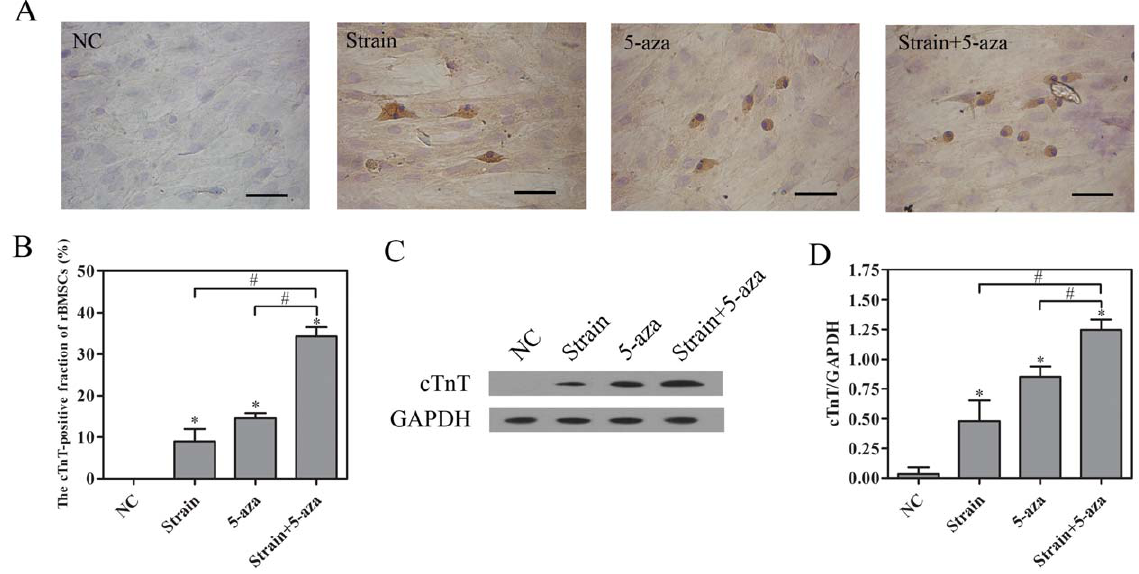
Figure 8. Effects of biochemical and physical stimuli on the expressions of cTnT in rBMSCs. rBMSCs were cultured under static conditions, or exposed to cyclic strain of 10% at a frequency of 1 Hz, or given 10 m M 5-aza, or treated with cyclic strain of 10% at a frequency of 1 Hz combined with 10 m M 5-aza for 24 h. The expression of cTnT was assessed on the 14 th day. (A) (B) Immunocytochemistry analysis of cTnT. Scale bar, 50 m m. (C) (D) Western blot analysis of cTnT. NC, negative control (rBMSCs treated with regular complete medium); PC, positive control (normal neonatal rat cardiomyocytes). Results are shown as the mean 6 SD values (n=3). * P , 0.05 compared to the NC group; # P , 0.05.